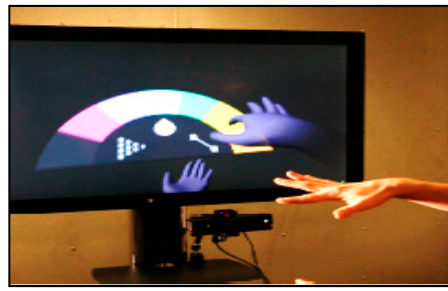
Figure 11. 3D hand model interaction with virtual system [83].